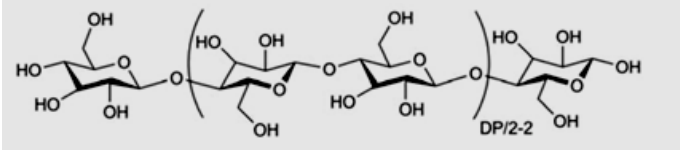
Figure 2. Cellulose structure (Reproduced with permission from [4], open access Creative Common CC licenced 4.0, MDPI).